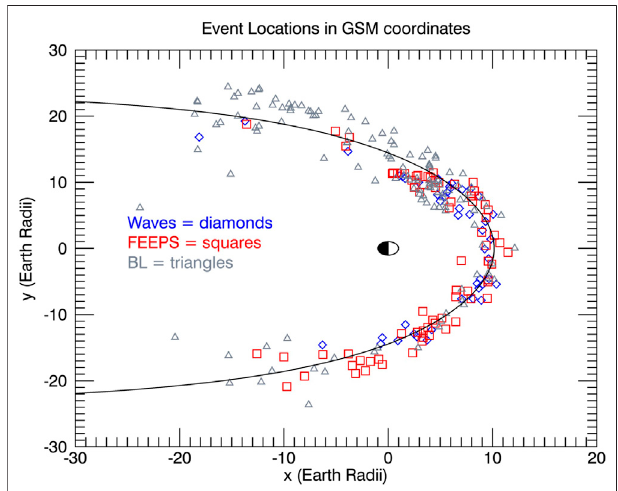
FIGURE3| Ascatter plotofxandypositionofboundarylayercrossings in GSM coordinates. The blue diamonds represent events with FEEPS enhancements and whistler waves, the red squares are events with FEEPS enhancements but no waves, and the gray triangles are boundary layer crossings with no FEEPS enhancements. The black line shows a typical magnetopause using a model and average data from Lin et al.